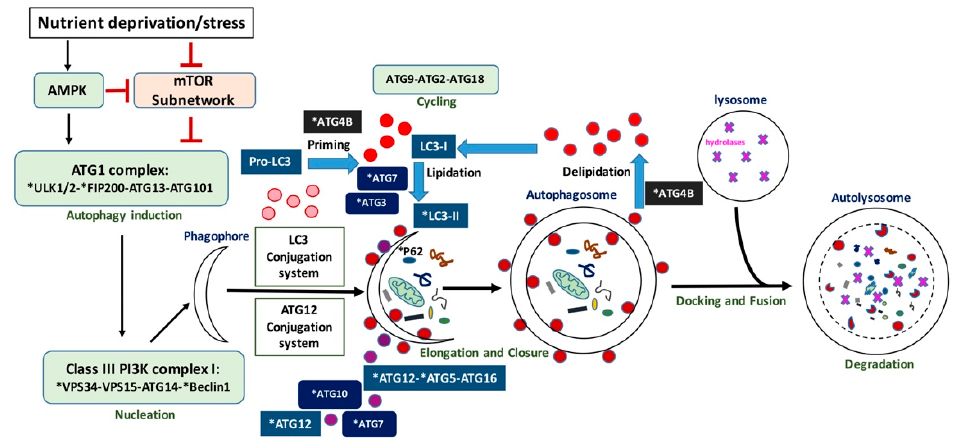
Figure 1. Schematic representation of autophagy. Autophagy proteins indicated with an asterisk have been investigated as potential biomarkers.